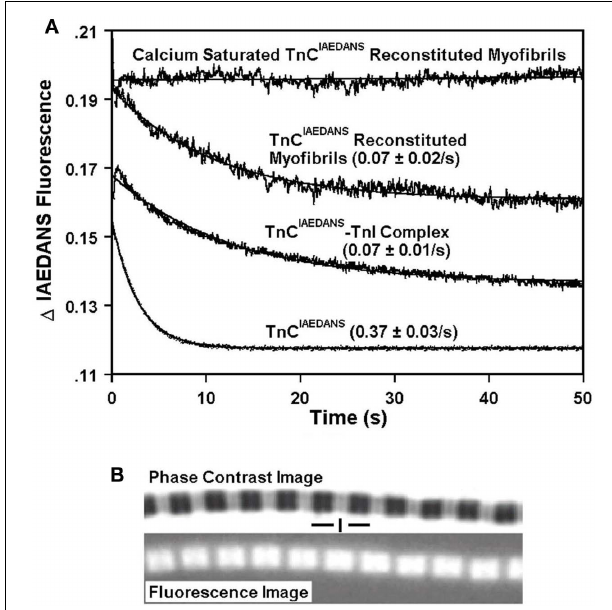
FIGURE 1 | Characterization of the Ca 2 + dissociation rates from TnC IAEDANS in isolation, in the presence ofTnI and in myofibrils. (A) Shows the time course of decrease in IAEDANS fluorescence as Ca 2 + was removed by EGTA from the C-terminal Ca 2 + -binding sites ofTnC IAEDANS ± TnI and in reconstituted myofibrils.TnC IAEDANS (0.6 μ M) ± TnI (1.2 μ M) in 10mM MOPS, 90mM KCl, 1mM Mg 2 + , 1mM DTT at pH 7.0 plus 200 μ M Ca 2 + was rapidly mixed with an equal volume of the same buffer plus 10mM EGTA at 15˚C. Similar experiments were performed with ∼ 1mg/ml reconstituted myofibrils except the buffer also contained 0.02%Tween-20. The flat line represents the fluorescence level of Ca 2 + saturated myofibrils in which EGTA in the second syringe was replaced with 200 μ M Ca 2 + . IAEDANS emission fluorescence was monitored through a 420- to 470-nm band-pass filter with excitation at 340nm.TheTnC IAEDANS andTnC IAEDANS –TnI complex traces have been normalized to that of theTnC IAEDANS reconstituted myofibrils trace and staggered for visual clarity. (B) Shows the phase contrast (top panel) and IAEDANS fluorescence (bottom panel) images obtained from a representative rigor psoas myofibril reconstituted with TnC IAEDANS .The vertical line designates the location of the Z-line, and the horizontal lines designate the location of the A